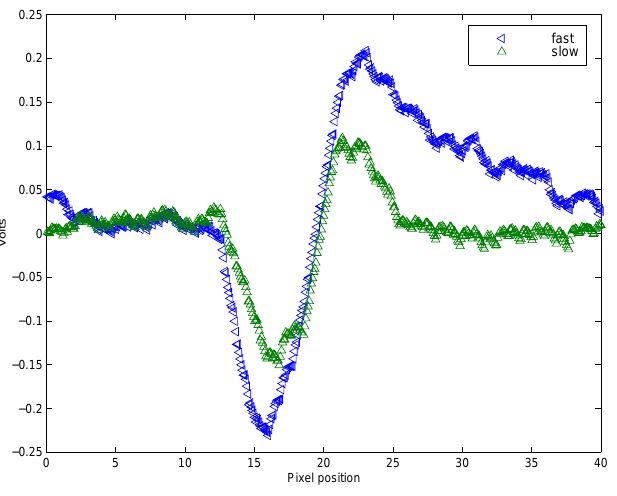
Figure 3 . Response of the array of adaptive photo-receptors, to a dark bar on a white background moving from right to left with an on-chip speed of 31mm/s. Depending on the value of the adaptation bias setting, the photo-receptors can be tuned to respond to specific velocities. The trace with wider amplitude (left pointing triangles) has an adaptation tuning for fast speeds, while the trace with the smaller amplitude (upward pointing triangles) has a slightly slower speed tuning. The DC value of both responses was removed for